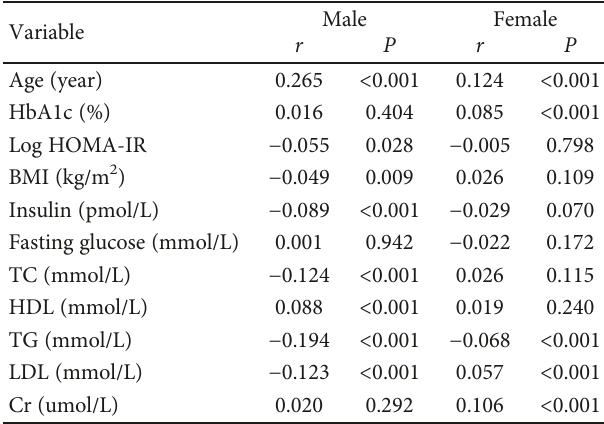
Table 3: Correlation of vitamin D with other parameters by